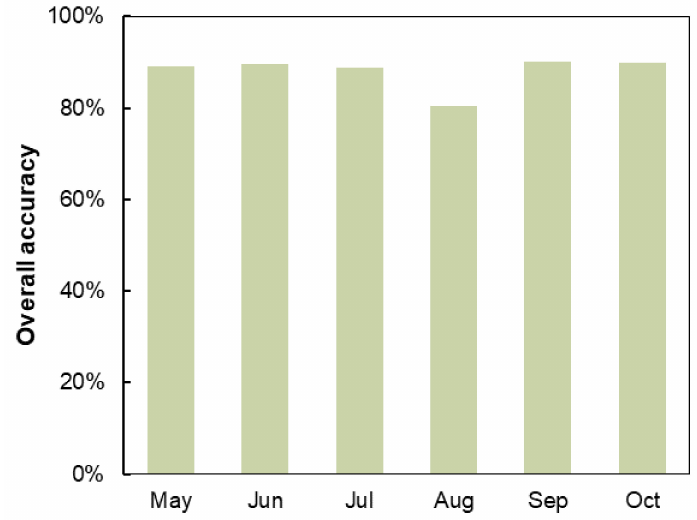
Figure 7. Validation of the accuracy of the proposed method per month using the samples collected in the corresponding months.